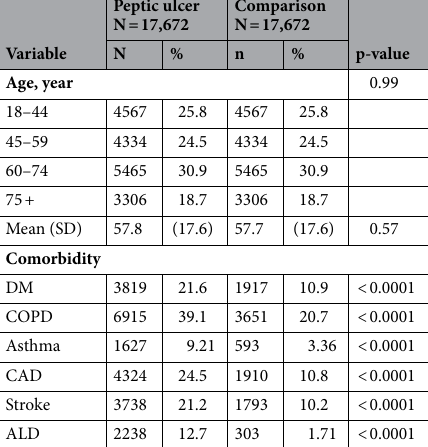
Table 1. Demographic status, and comorbidity of study cohorts. ALD alcohol-related disease, CAD coronary artery disease, COPD chronic obstructive pulmonary disease, DM diabetes mellitus, SD standard deviation. Chi-square test, and